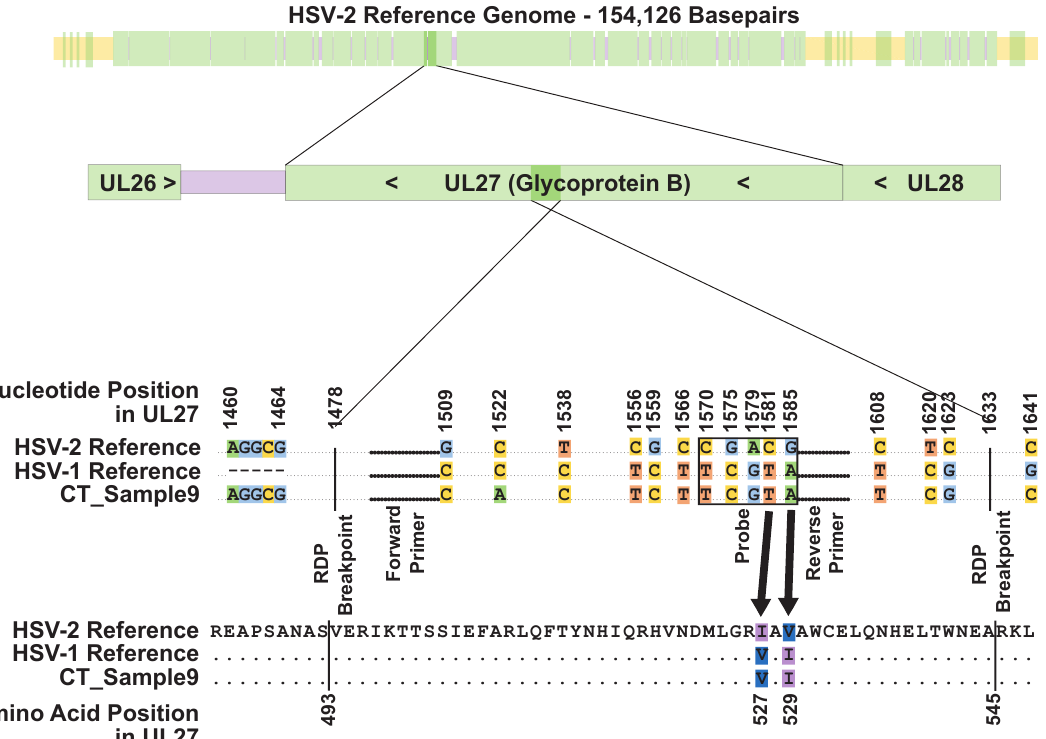
Figure 1. Nucleotides involved in the recombination event in UL27. The top bar shows the location of the UL27 gene (shown in dark colors) within the HSV-2 genome (faded out). Genic regions in the HSV-2 genome are shown in green, while intragenic sequences outside the terminal and internal repeat regions are in purple. Intragenic regions within the terminal and internal repeat regions are in yellow. The second bar shows UL27 in its genic neighborhood with the recombinant region highlighted. UL27 is in reverse orientation in the HSV genome. In the alignment, nucleotides that are identical in all sequences are represented by dots, while nucleotides that di ff er among sequences are represented by letters. Dots shown in bold represent the locations of the forward and reverse primers, as labeled. The probe region is boxed. Recombination event breakpoints, as identified by the recombination detection program (RDP), are labeled. Non-synonymous di ff erences between HSV-1 and HSV-2 are indicated with arrows pointing to the corresponding amino acid changes.